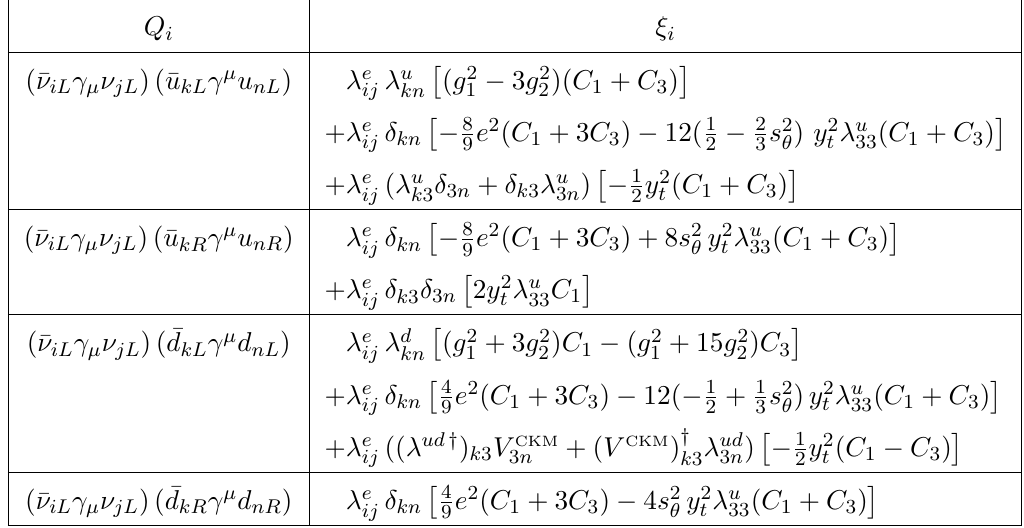
Table 3 . Operators Q i and coe(cid:14)cients (cid:24) i for the semileptonic part of the e(cid:11)ective Lagrangian L EW involving neutrinos and neutral currents. Generation indices run from 1 to 3, exception made for up-type quarks where k; n = 1 ; 2. We set sin 2 (cid:18) W (cid:17) s 2